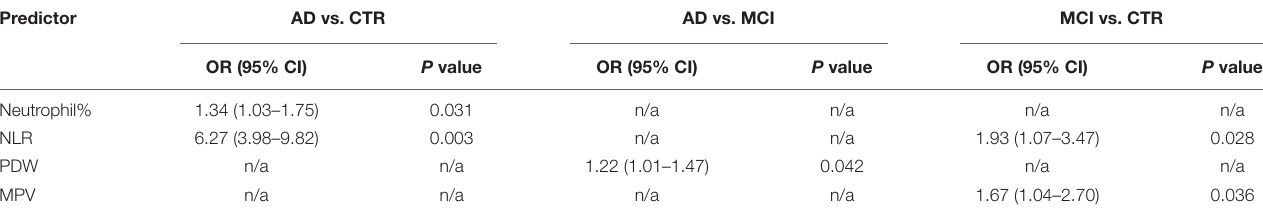
TABLE 2 | Multivariate models for distinguishing between diagnostic groups.